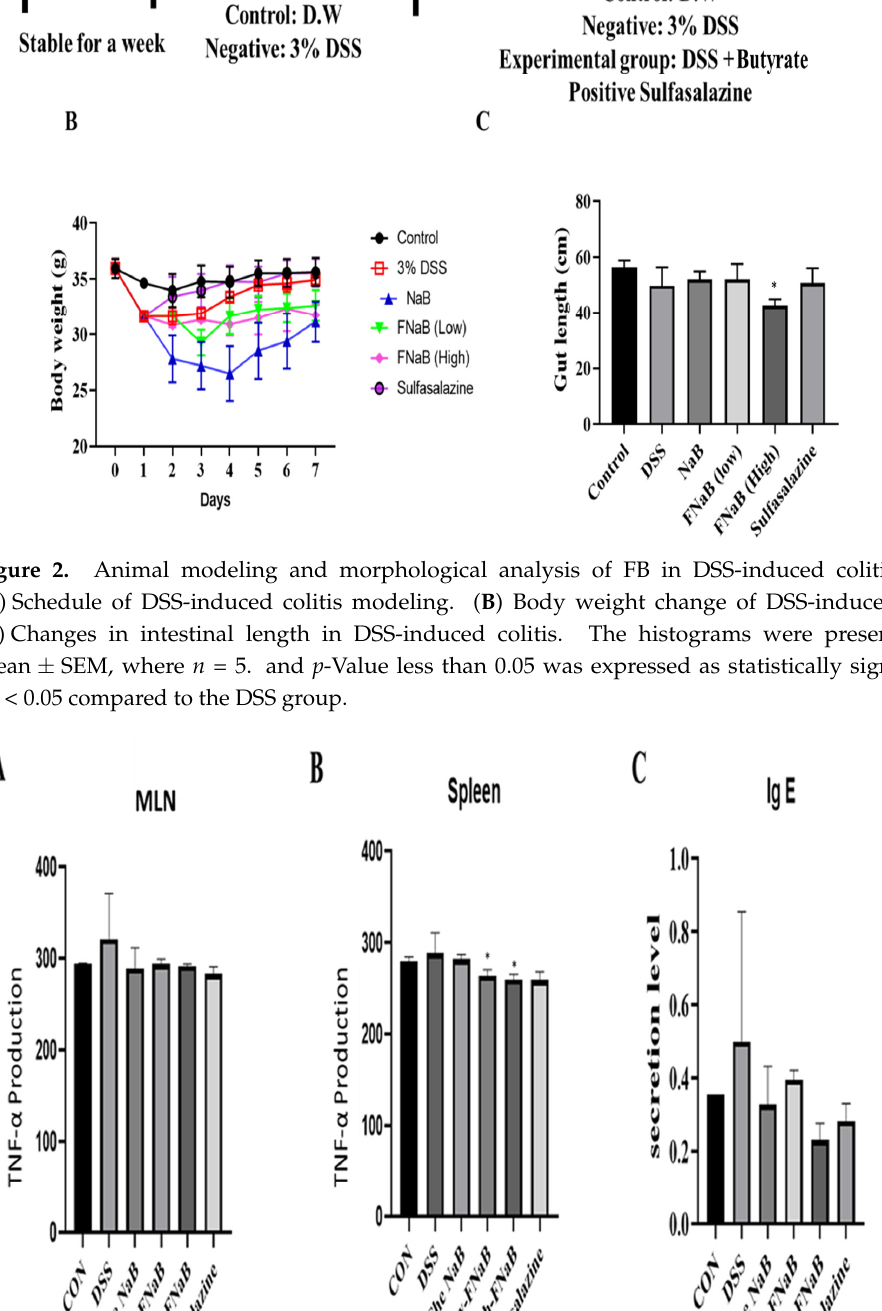
The DSS-induced colitis model is known to cause inflammation only in the large in- testine. We isolated MLN and spleen from colitis mice and quantified the secretion of cy- tokine TNF- α . The TNF- α level was measured using an ELISA kit and, in the MLN and in the spleen, TNF- α level increased in the DSS group, decreased only in MNL in animals that ate NaB, and decreased in both the FB groups (low and high group) and the positive groups. Finally, the immune factor Ig-E level was measured. Serum was separated from the blood of each animal and measured (Figure 3C). The Ig-E level was increased in ani- mals induced colitis with DSS, and the IgE level was decreased in NaB, FB, and positive control groups. These results suggested that FB shows anti-inflammatory efficacy in the intestines of animals with colitis, and further decreases in TNF- α and IgE also affect sys- temic immunity. 3.5. Histology of Large Intestine in DSS-Induced Colitis Mice Finally, we observed morphological changes in the large intestine tissues of DSS-in- duced colitis mice (Figure 4). The lengths of the epidermis and the dermis were signifi- cantly reduced in the large intestine of DSS-induced colitis mice (Figure 4B). On the other hand, a morphologically significant recovery was observed in the group fed NaB (Figure 4C). However, a low-concentration intake in FB administered mice also showed morpho- logical recovery (Figure 4D), and many recoveries were confirmed in animals treated with high-concentration FB (Figure 4E). In these results, FB contributes to the morphological recovery of the large intestine but not a full recovery. This result showed similar results to the relationship between the length of the field in Figure 2C.